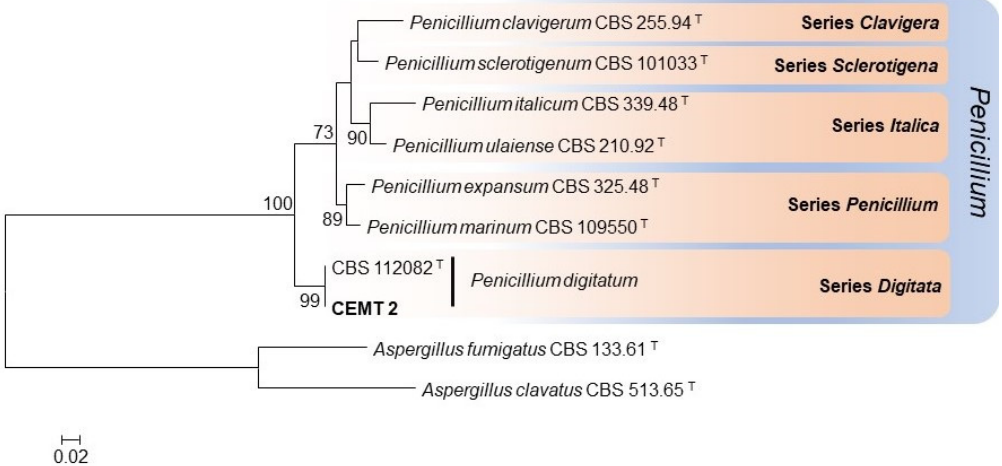
Figure 3. Maximum-likelihood phylogenetic tree constructed with β -tubulin sequences from 7 rep- resentative species of the series Clavigera, Sclerotigena, Italica, Penicillium , and Digitata . Bootstrap values ≥ 70% are indicated in the nodes. The fungal strain of the present study is indicated in bold. Branch lengths are proportional to phylogenetic distance. T: Ex-type species.